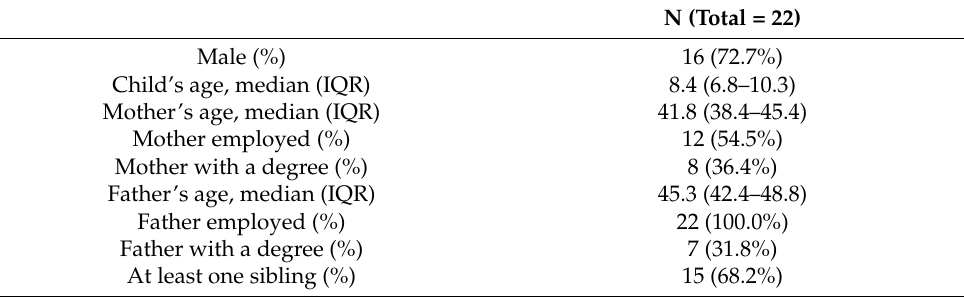
Table 1. Characteristics of the